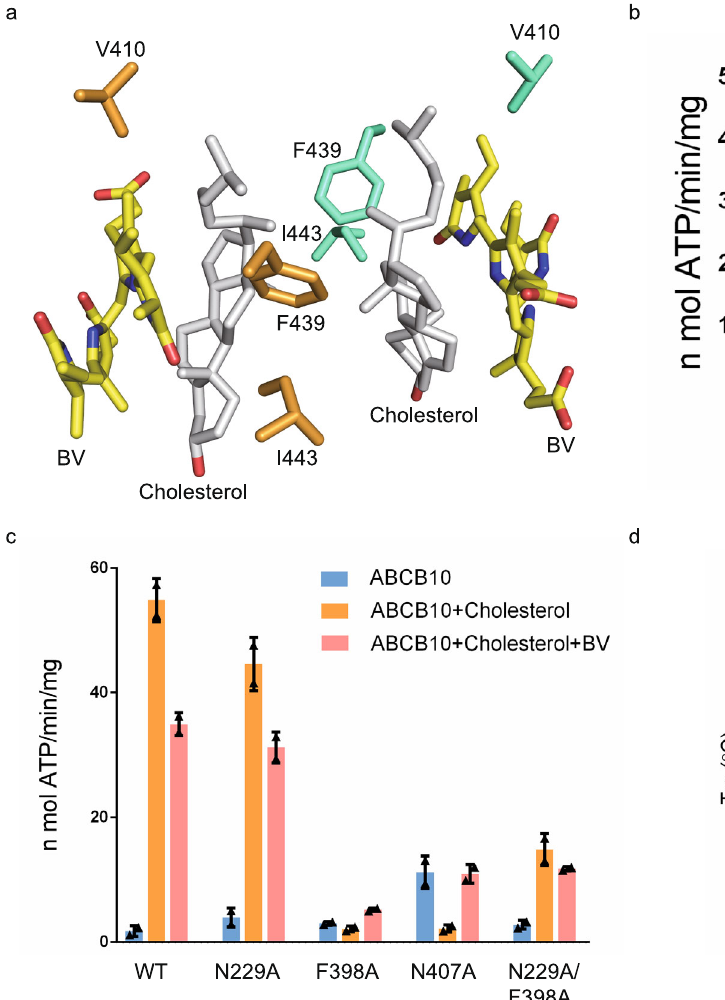
mutants. ATPase activities are measured at varied concentration of ABCB10 WT or mutant in the presence of absence of cholesterol and biliverdin. Each data is pre- sented as the means±s.d. of three independent assays ( n =3). d Cholesterol in fl u- encesthethermalstabilitiesofABCB10WTandmutants.Themeltingtemperatures (Tm)of ABCB10aremeasuredbyperforming thermo fl uorshift assays.Eachdatais presented as the means±s.d. of three independent assays ( n